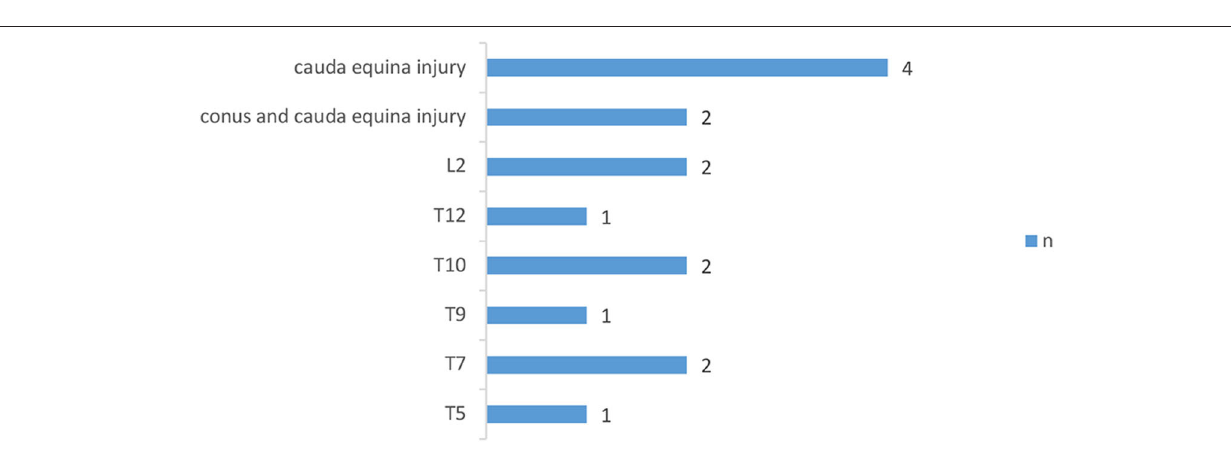
FIGURE 2 | Distribution of neurologic levels of injury in incomplete SCI patients. T, thoracic levels; L, lumbar levels; (30) n,